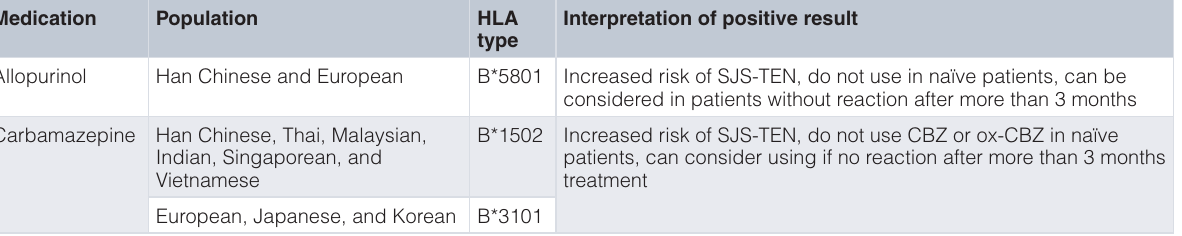
Table 4. Medication causes of SJS-TEN with strongly predictive (100%) HLA associations 35